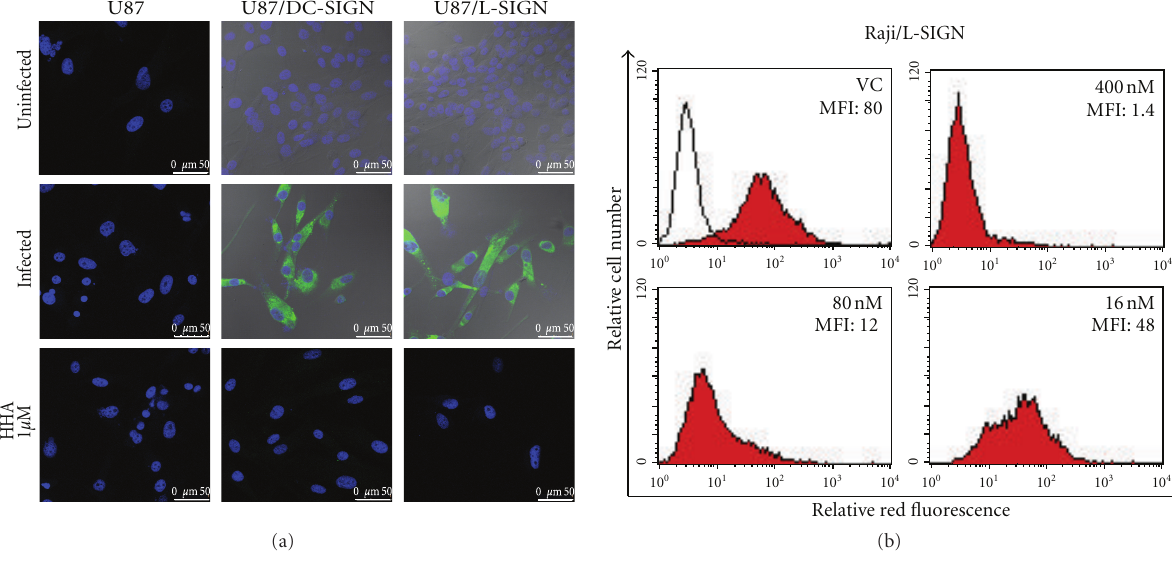
Figure 4: Antiviral activity of HHA in DC-SIGN and L-SIGN transfected cell lines. (a) U87, U87/DC-SIGN, and U87/L-SIGN cells were infected with DENV-2 in the presence or absence of HHA. DENV-2 infection was analyzed by confocal microscopy using specific DENV antibodies as previously described [62]. The cell nucleus is shown in blue (Dapi) and DENV-2 infected cells are shown in green (anti-DENV Ab + Alexa 488). (b) Raji/L-SIGN cells were infected with DENV-2 in the presence or absence of HHA, and viral infection was analyzed by flow cytometry using specific DENV antibodies. The open histogram represents uninfected cells. The upper left red histogram shows the virus control (VC), and the mean fluorescence of intensity (MFI) is indicated in each panel. HHA was added at di ff erent concentrations (400–80–16nM), and the MFI shows the dose-dependent inhibition of the DENV-2 infection in Raji/L-SIGN cells. Comparable antiviral activity of HHA in Raji/DC-SIGN cells was obtained